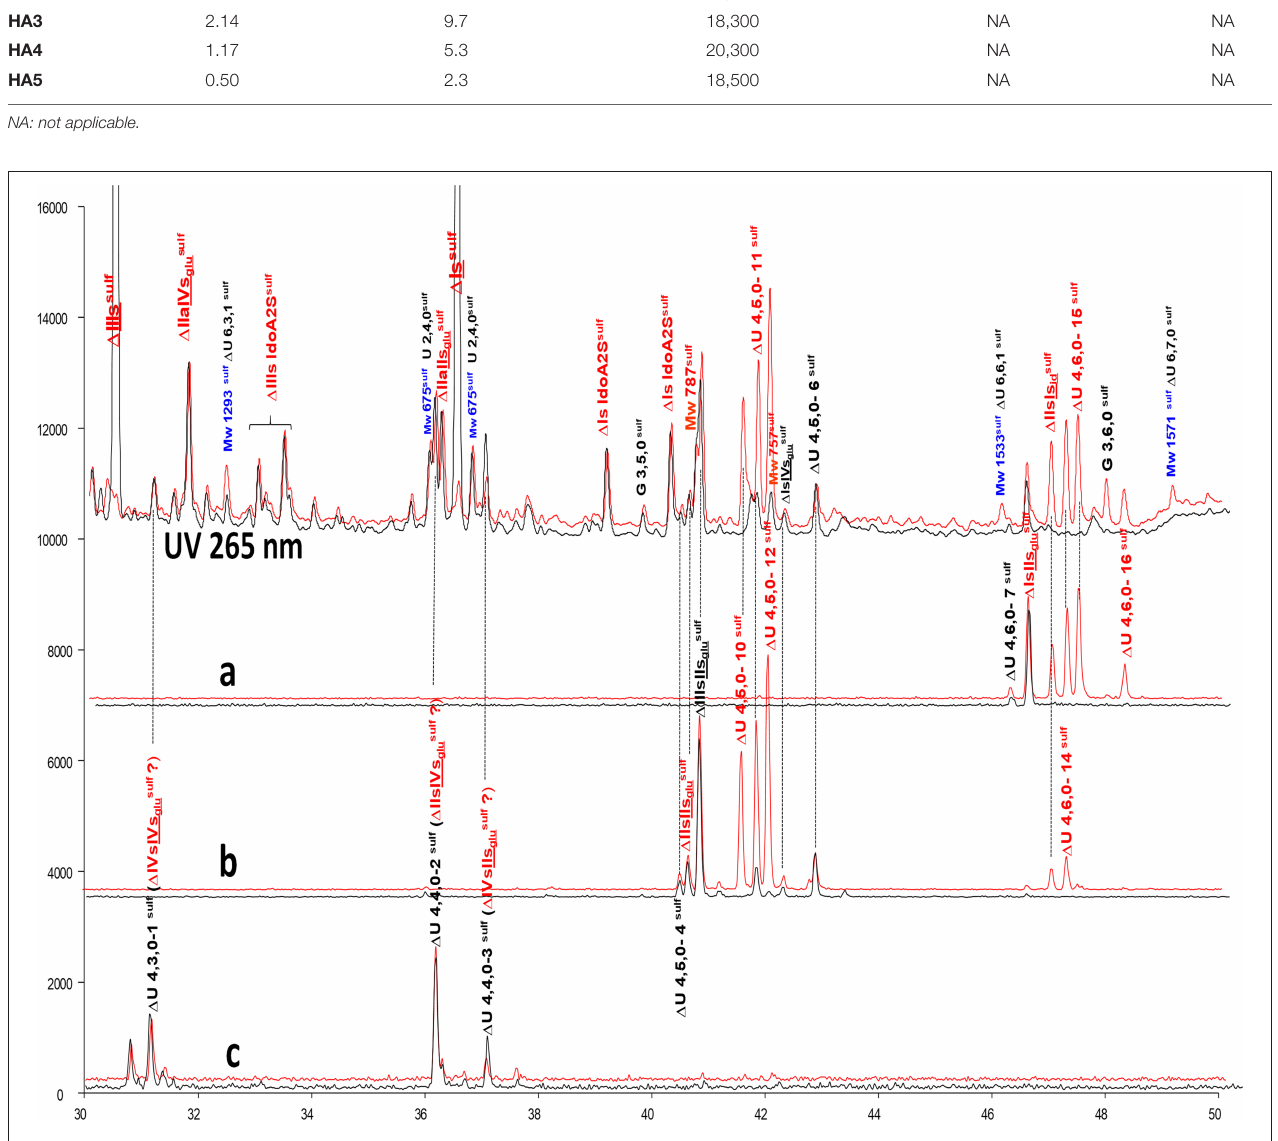
FIGURE 5 | Comparison by ion-pair liquid chromatography/mass spectrometry of heparinase I + II + III ( — ) and heparinase II ( — ) digests of bovine mucosal heparin low-affinity (LA) fraction after sulfanilic reductive amination. (a) Reconstructed ion pair chromatograms (RIC) 1 U(4,6,0) sulf : m/z 712.2; (b) RIC 1 U(4,5,0) sulf : m/z 614.5 + 672.1; (c) RIC 1 U(4,4,0) sulf + 1 U(4,3,0) sulf : m/z